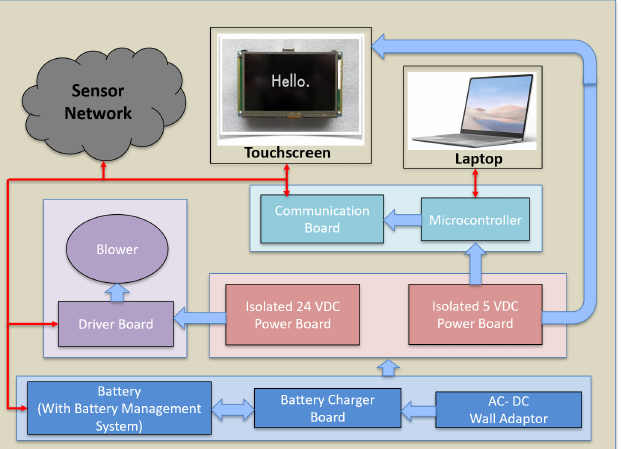
Figure 3. The architecture of the servoregulator with main power and electronics components labeled. The solid blue arrows represent power lines while the red arrows depict communication